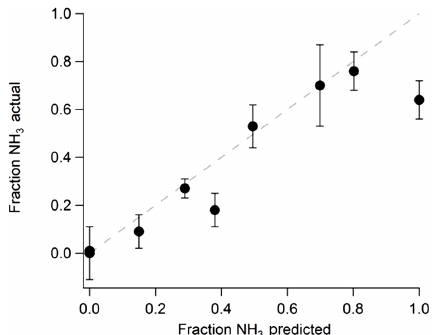
Figure 1. Fraction of NH 3 liberated during drying experiments vs. the fraction predicted according to an updated Eq. (2) to include ac- etate, formate, CO 2 − , and HCO − in the anion balance. Excluding 3 3 these anions significantly reduces the correlation. Error bars repre- sent ± σ from three experiments per synthetic dew. The dashed line is the 1:1 line.